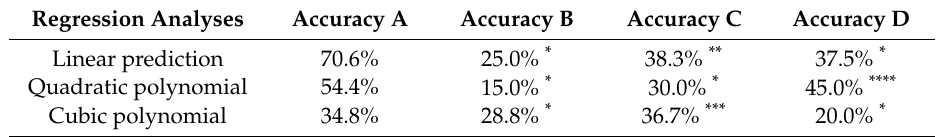
Figure 2. ( a ) Regression analytic graphs are exemplified. Left side shows the result of “single cell”, and the right shows “IDH”. The vertical axis is the fold value of Δ -AII. The upper row is the result of linear prediction, the middle is quadratic polynomial and the lower is cubic polynomial. The circles are actual measured values and the triangles are predicted values. ( b ) Regression analytic predictions of “CRISPR”, “Cas 9” and “RNA-guided”. The vertical axis is the fold value of ∆ -AII. The analyzed AII is the sum of these three keywords’ AII. Other arrangements are the same as Figure 2a. Table 2. Accuracy of the predictions by multiple regression analyses.